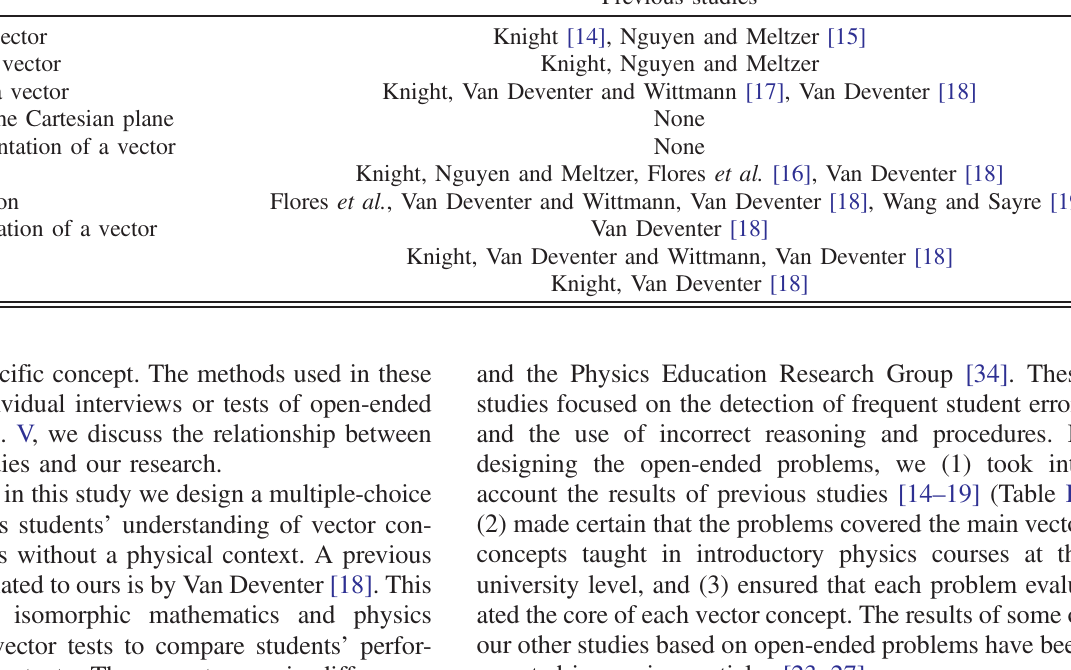
TABLE I. Ten vector concepts used in the introductory courses. For each concept we note the previous studies that identify students ’ errors. Vector concept Previous